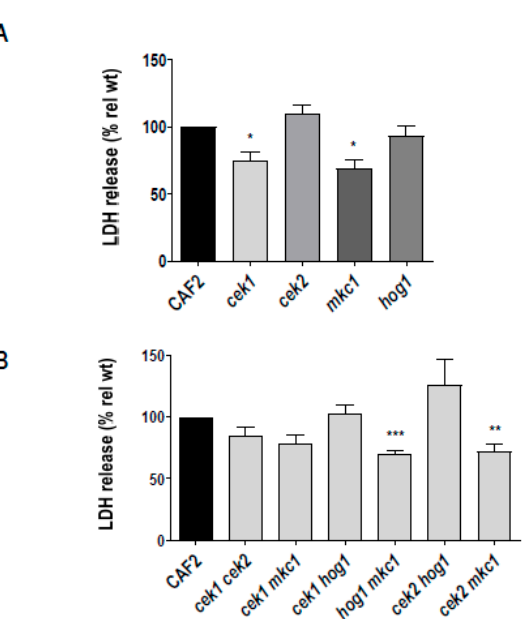
Figure 4. Damage of oral epithelial cells by C. albicans MAP kinase defective strains. 2 × 10 4 C. albicans cells were incubated with a TR146 cell line monolayer for 24 h. Damage of the epithelial cells was quantified by measuring the release of lactate dehydrogenase (LDH) into the surrounding medium. Damage for each strain was normalised to the wild type damage (CAF2). Errors bars represent the SEM of at least three independent experiments., * p < 0.05, ** p < 0.01, *** p < 0.005.